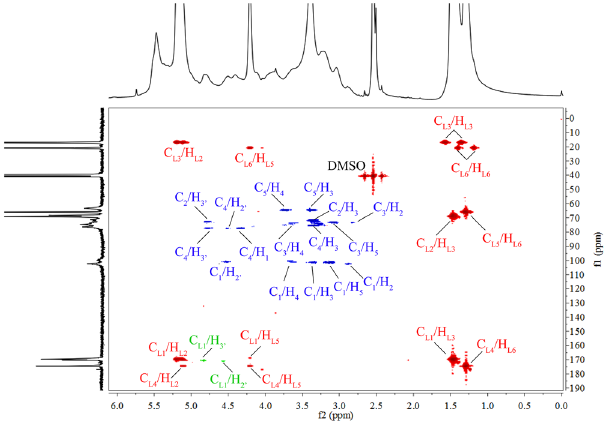
Figure 5. 1 H- 13 C HMBC spectrum of xylan- g -PLA copolymer sample 21 (DS =